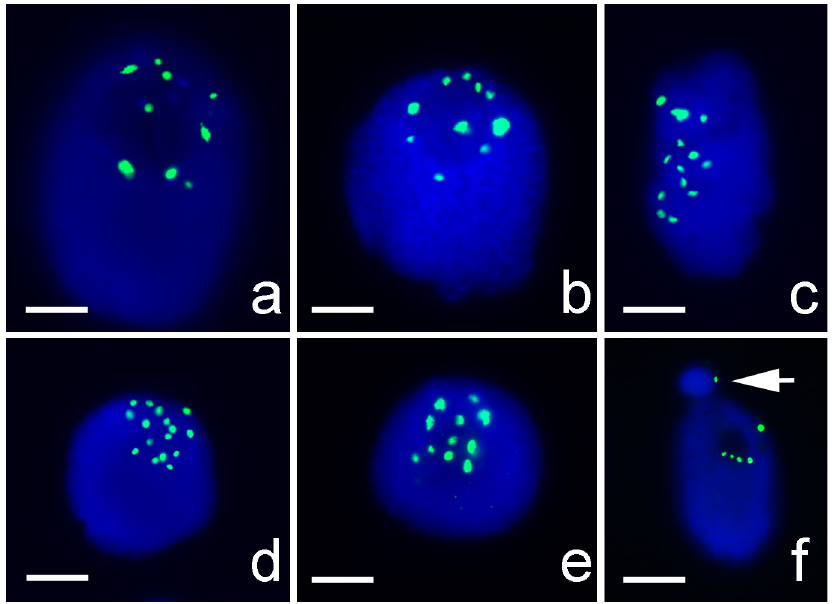
Fig 5. Immunostaining of interphase nuclei of an artificial hybrid L . aurea × L . radiata (2n = 18, 4M+3T+11A) using an anti-LaCENH3 antibody. (Scale bar = 10 μ m). Immunostaining signals (green) are visible in interphase nucleus (blue) of root-tip meristem. Fluorescent signals in various size and intensities indicate different abundance of LaCENH3 proteins at individual centromeres. Arrow points to a micronucleus with immunostaining signals.